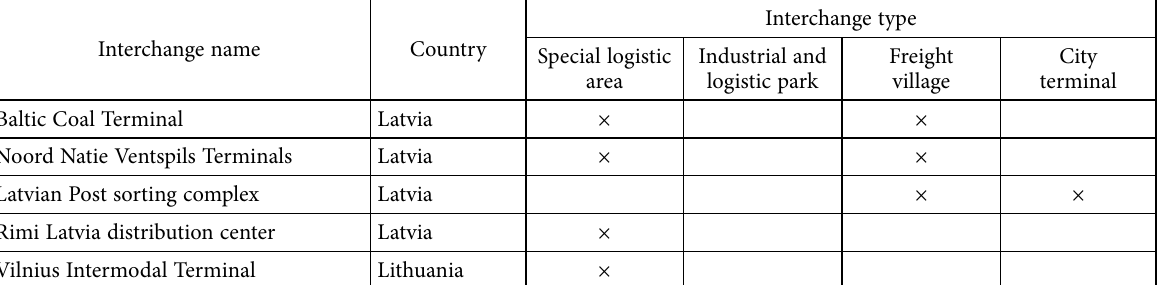
Table 4. Overview of freight interchanges in Latvia and the